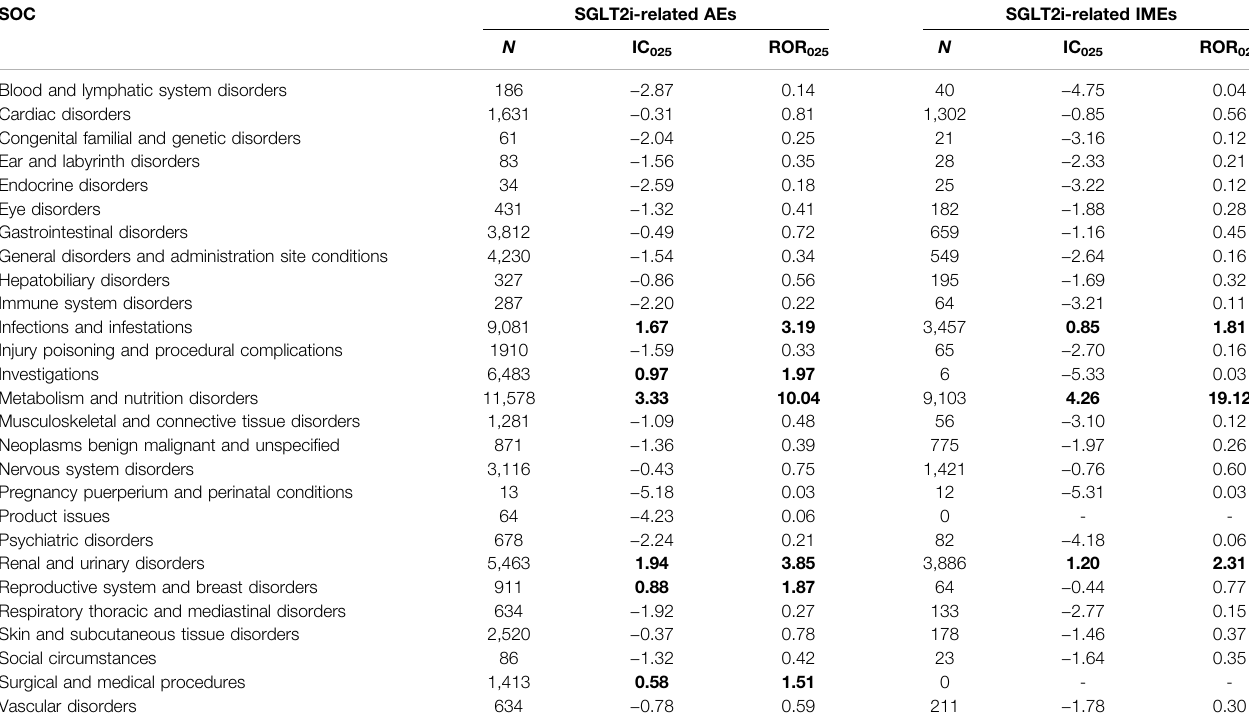
TABLE 3 | Signal strength of SGLT2i and AEs/IMEs at the System Organ Class (SOC) level a .